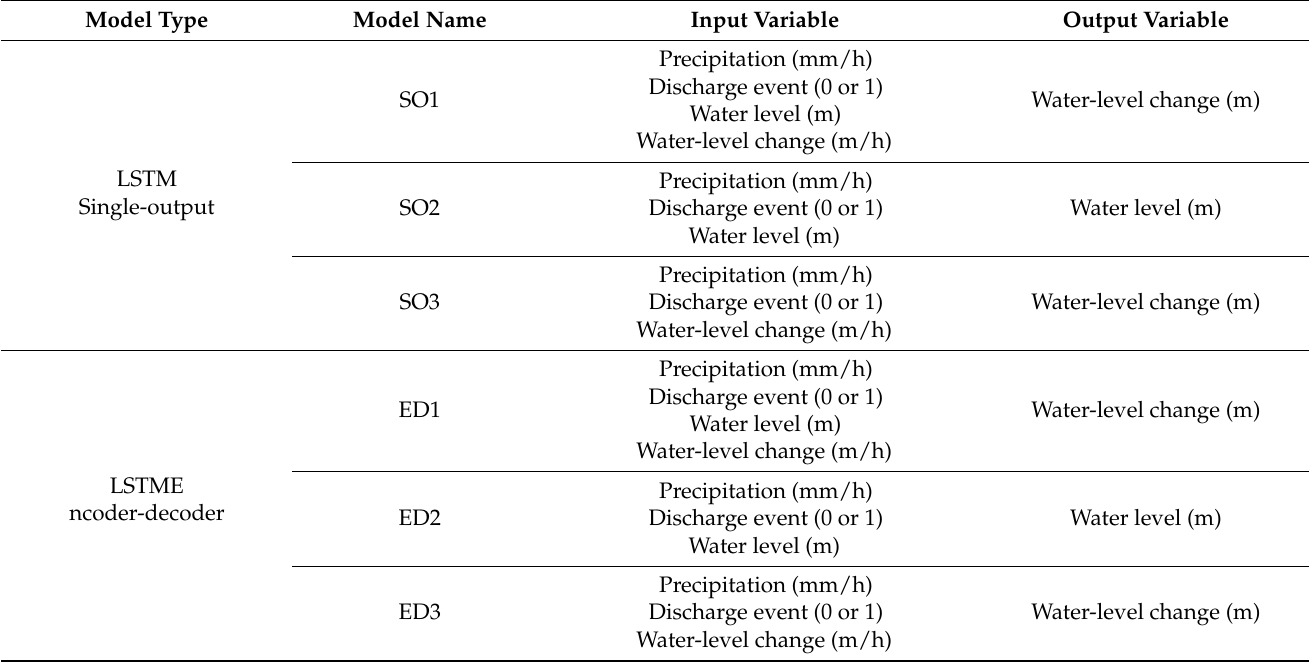
Table 2. Types of models developed and their input and output